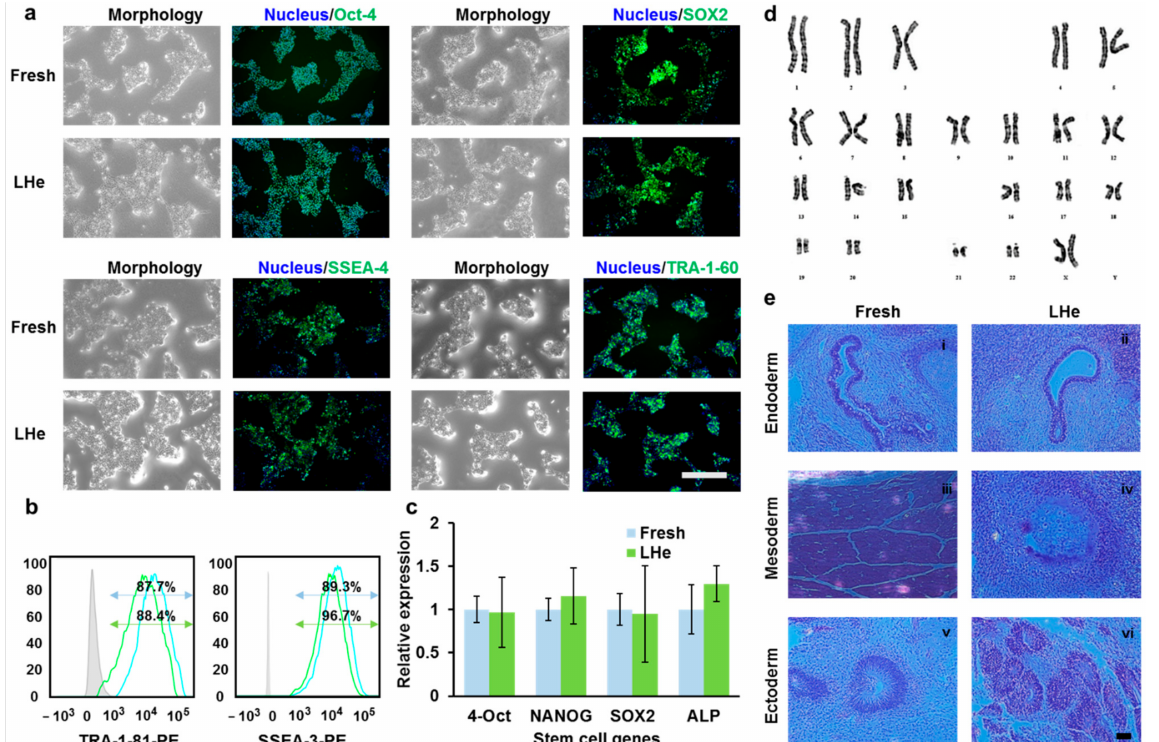
Figure 7. The hESCs retained pluripotency after vitrifying in LHe, indicated by the expression of typical genes and antigens, a normal karyotype, and teratomas formation. ( a ) Immunofluorescence staining indicated that vitrified hESCs showed stem cell markers: Oct-4, SOX2, SSEA-4, TRA-1-60. ( b ) Flow cytometry quantification of the expression of SSEA-3 and TRA-1-81 showed no significant difference between fresh (blue) and vitrified (green) hESCs. ( c ) The RT-qPCR analysis confirmed the relative expression of three hESC genes (4-Oct, NANOG, SOX2) was not influenced after vitrifying in LHe. There was no significant difference between group Fresh and LHe. ( d ) Vitrified hESCs retained a normal karyotype. ( e ) Pluripotency of hESCs vitrified in LHe. Fresh and vitrified hESCs developed into a teratoma when transplanted subcutaneously into SCID mice. Hematoxylin and eosin (H&E)-stained sections of ( i , ii ) respiratory epithelium (endoderm), ( iii ) muscle-like structure (mesoderm), ( iv ) cartilage-like structure (mesoderm), ( v , vi ) neuroepithelium (ectoderm). Scale bars: 200 µ